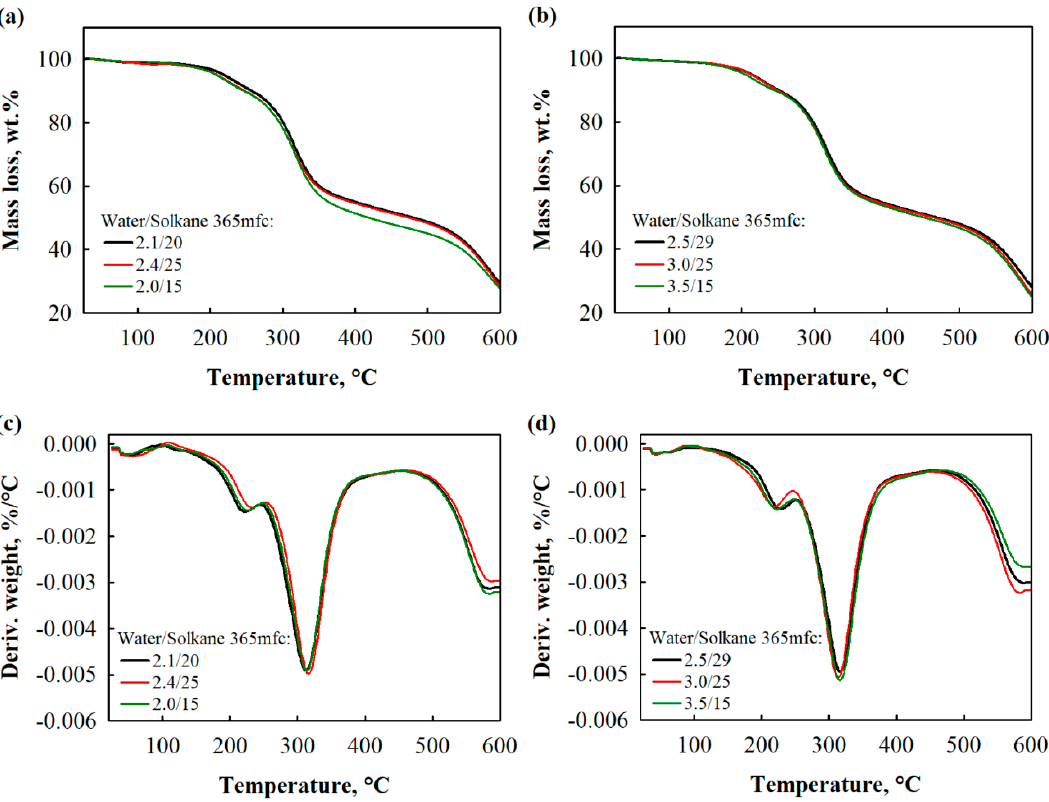
Figure 7. Thermogravimetry (TGA) and differential thermogravimetry (DTG) curves of polyurethane foams at an apparent density of ( a , c ) 40 kg / m 3 and ( b , d ) 30 kg / m 3 . Table 7. Thermal degradation parameters of the stable polyurethane